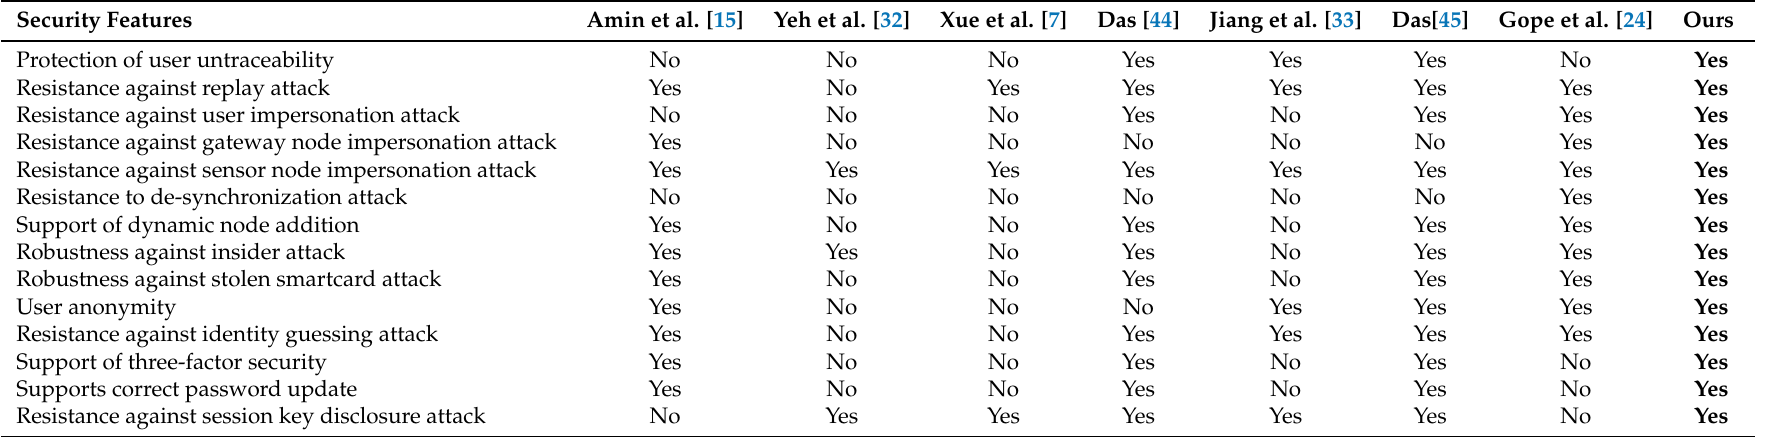
Table 3. Security features’